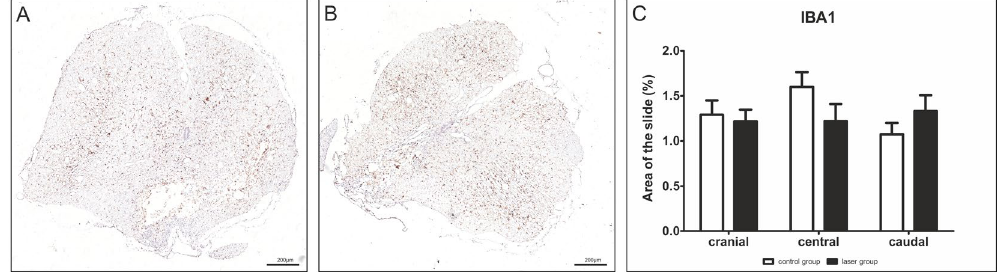
Figure 7. Effect of PBM on microglia/macrophages using IBA1 staining. ( A , B ) Representative images of IBA1- stained cross sections 9 weeks after the SCI at the caudal part of the injury site. ( A ) – laser group, ( B ) – control group. ( C ) We found no significant difference between the laser-treated and control groups in cranial ( − 3 mm, − 2 mm), central ( − 1– + 1 mm) and caudal ( + 2 mm, + 3 mm) parts of the lesion center. n = 6 per group. The values are expressed as mean ± SEM.